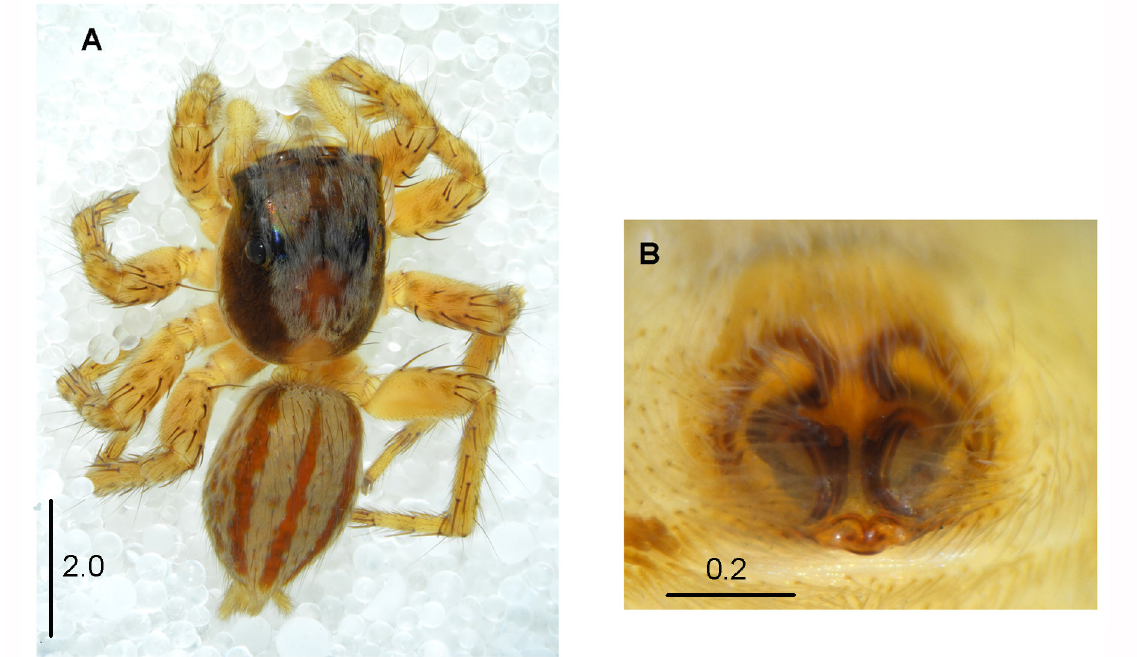
Fig. 60. Saraina rubrofasciata Wanless & Clark, 1975, ♀ (MNHN). A . Habitus, dorsal view. B .